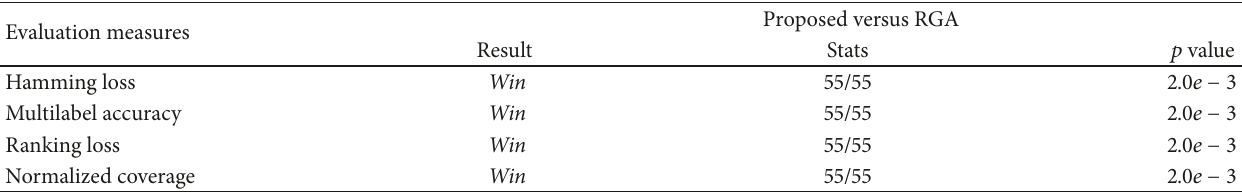
Table 5: Wilcoxon signed-rank test results for the proposed method against RGA for Genbase dataset with a significance threshold of 𝛼 = 0.05 , sum of outperformed rank 𝑅 + over the total rank and 𝑝